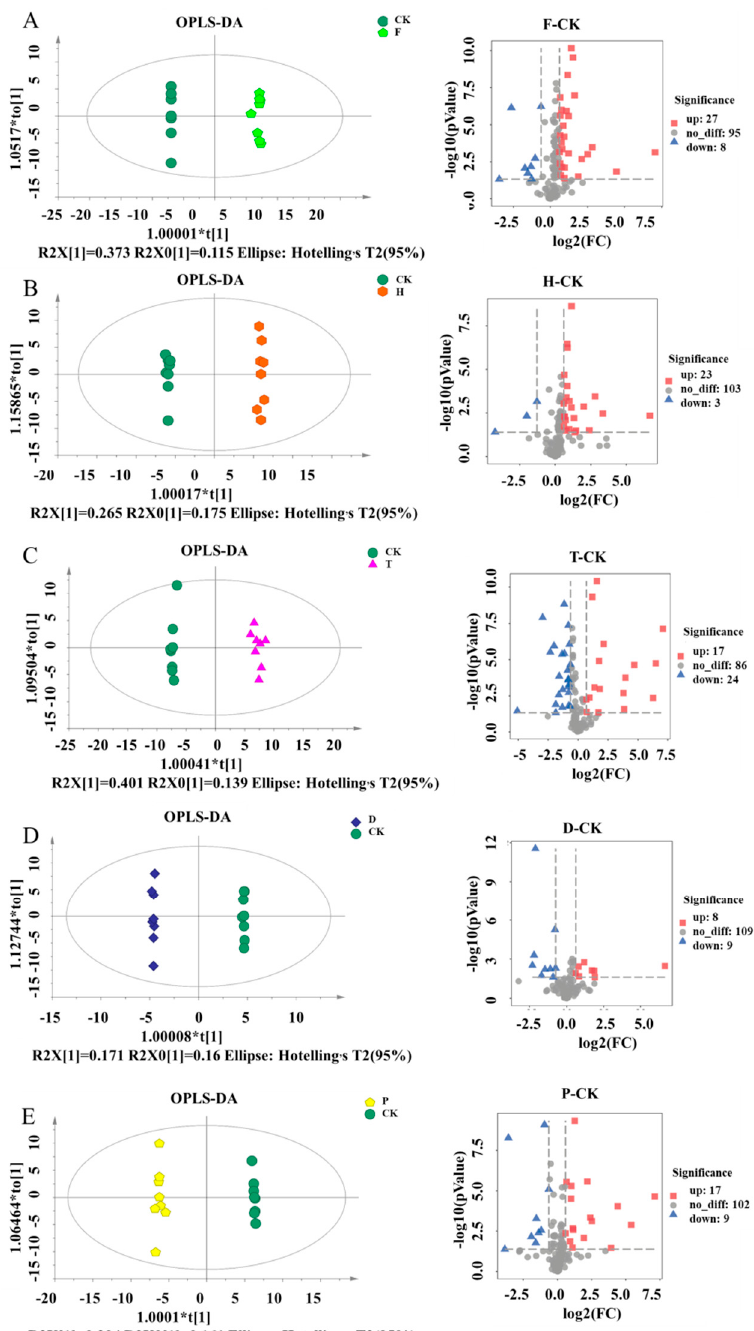
Figure 4. OPLS-DAand Volcano map of changed metabolites during wine brewing with the treatment of F, H, T, D, and P. ( A ) CK and F; ( B ) CK and H; ( C ) CK and T; ( D ) CK and D; ( E ) CK and P. All collected data are within the 95% confidence interval. Red represents the CK group, yellow represents the F group, light blue represents the H group, purple represents the T group, green represents the D group, blue represents the P group, and light purple represents the QC group. Note: CK, blank control group; F, flutriafol; H, hexaconazole; T, tebuconazole; D, difenoconazole; P, propicon- azole.